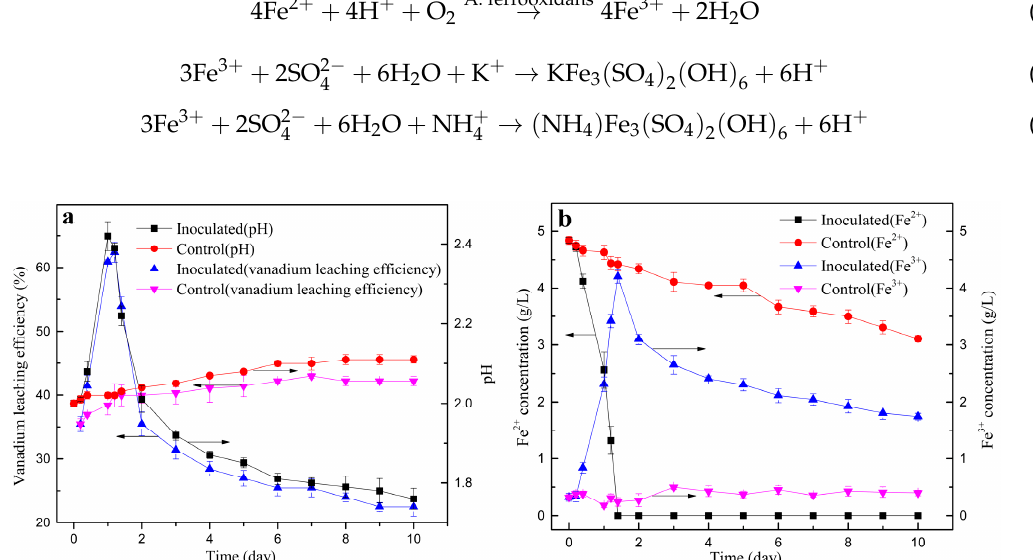
Figure 7. Vanadium leaching efficiency and pH ( a ), the concentrations of Fe 3+ and Fe 2+ ( b ) in leach liquors during the bioleaching of vanadium-bearing shale.